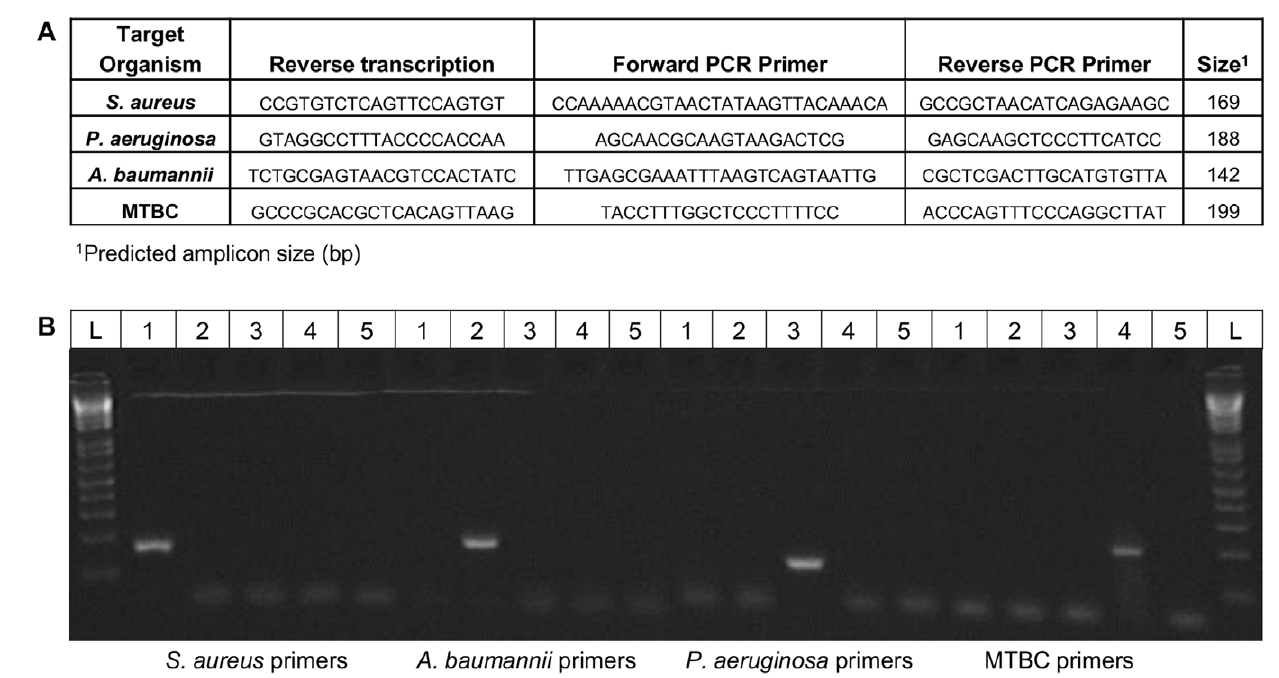
Figure 1. Reverse transcription and PCR primers. A: Oligonucleotides used for priming reverse transcription of pre-rRNA (cDNA synthesis), and forward and reverse PCR primers for amplifying cDNA. B: Specificity of PCR primer sets designed for S. aureus, A. baumannii, P. aeruginosa , and MTBC. Each primer set was used in endpoint PCR conducted on purified DNA from all the four organisms. Key: L, 1 Kb + DNA ladder; 1, S. aureus DNA; 2, A. baumannii DNA; 3, P. aeruginosa DNA; 4, M. tuberculosis DNA; 5, negative control (water). Lowest three bands of ladder are 100, 200, and 300 bp. A repeat experiment yielded identical results.